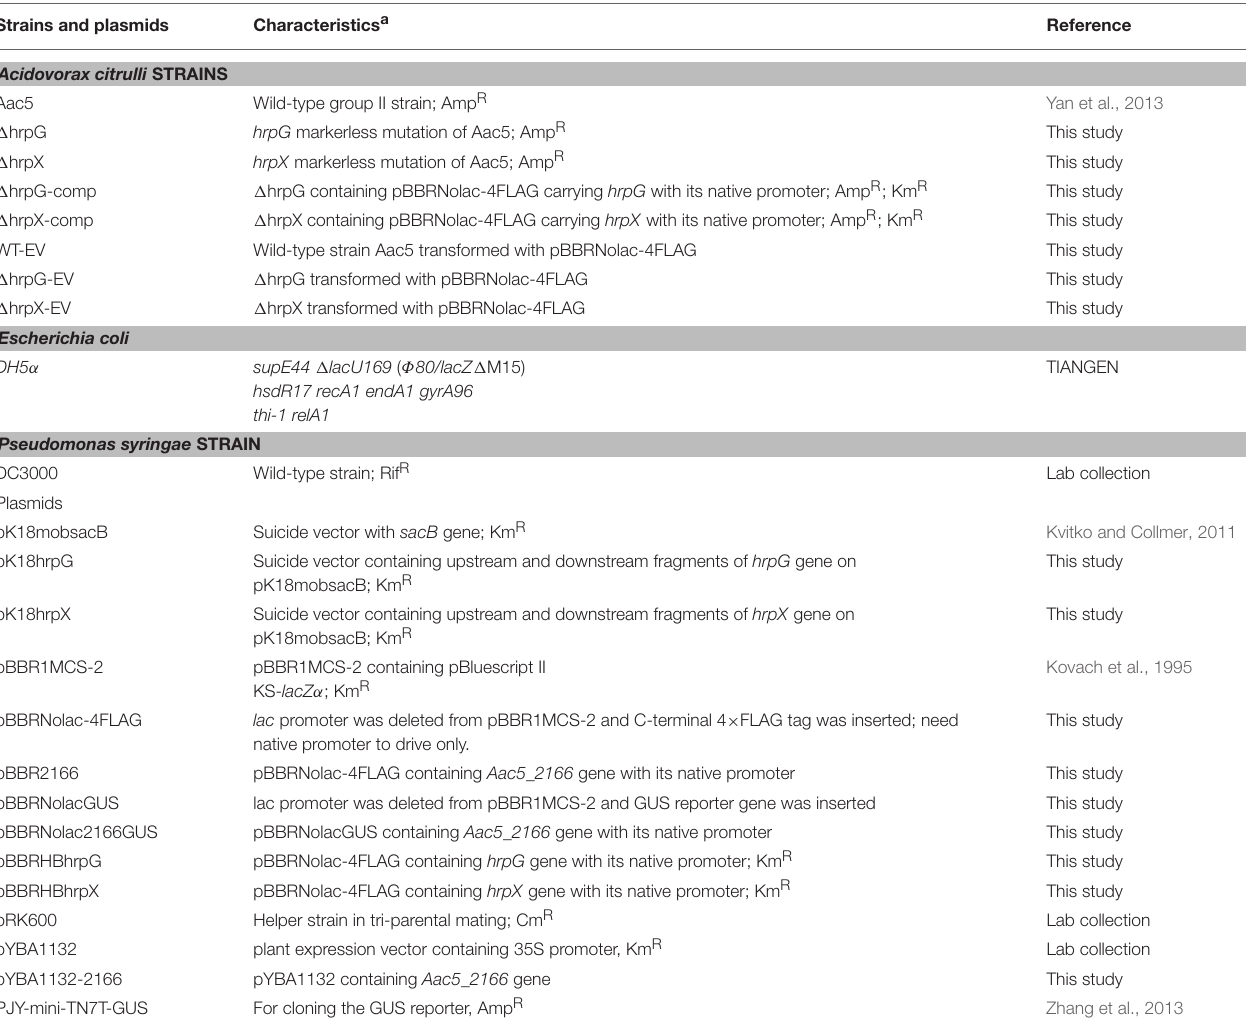
TABLE 1 | Bacterial strains and plasmids used in this